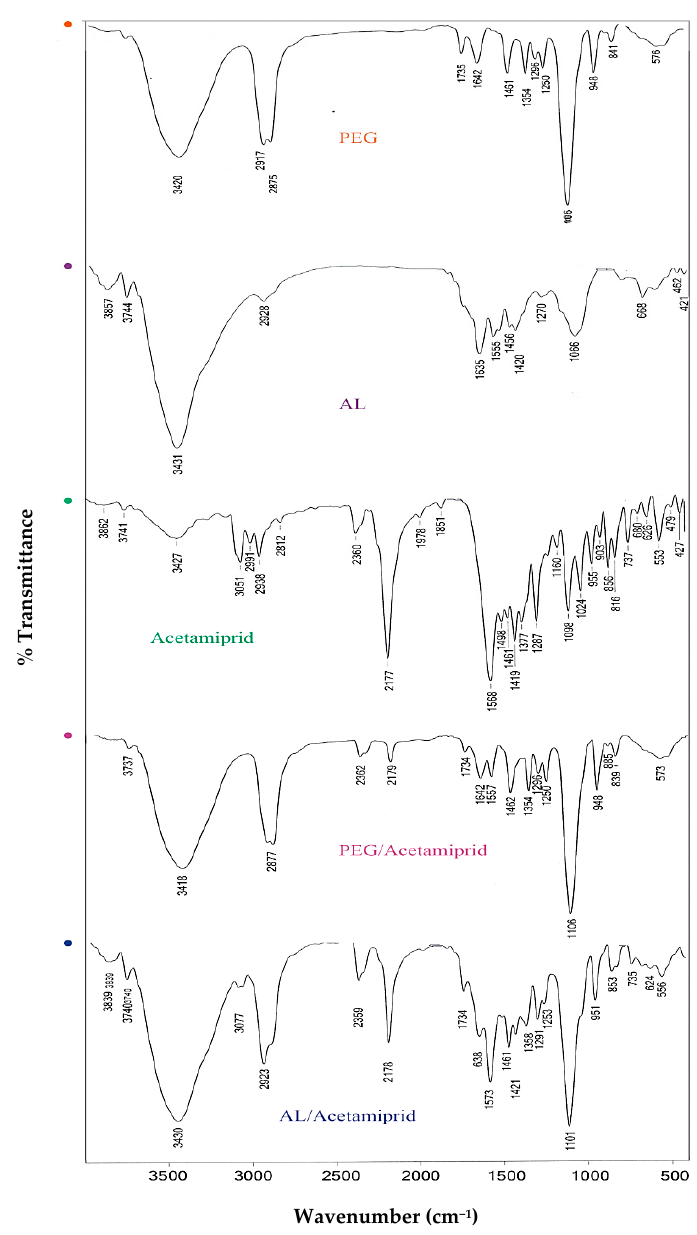
Figure 3. FTIR spectra of PEG, AL, Acetamiprid, AL–acetamiprid, and PEG–acetamiprid.